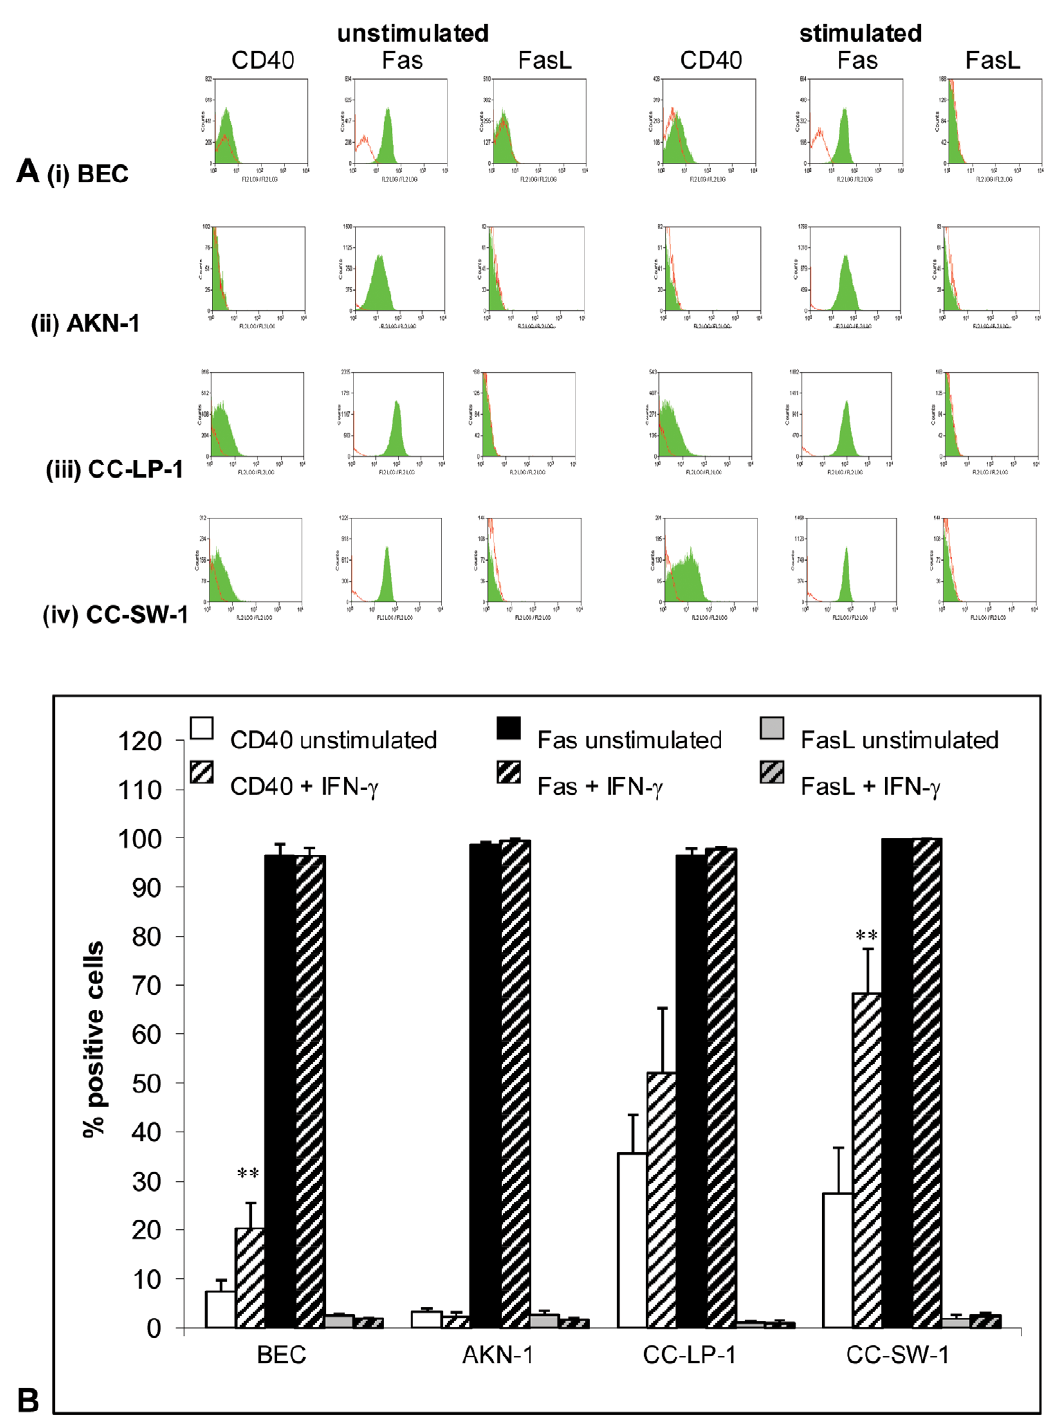
Figure 1. Expression of CD40, Fas and FasL protein on the cell surface assessed by flow cytometry. Cells were grown in media alone or stimulated with IFN- c at 50 ng/ml for 48 hours. (a) flow cytometry histograms of matched isotype control (red outline) and CD40, Fas and FasL expression (green solid colour) (b) shows the percentage positive cells for CD40, Fas and FasL protein. n=3 + / 2 standard deviation. *p , 0.05, **p , 0.01 as compared to untreated controls.